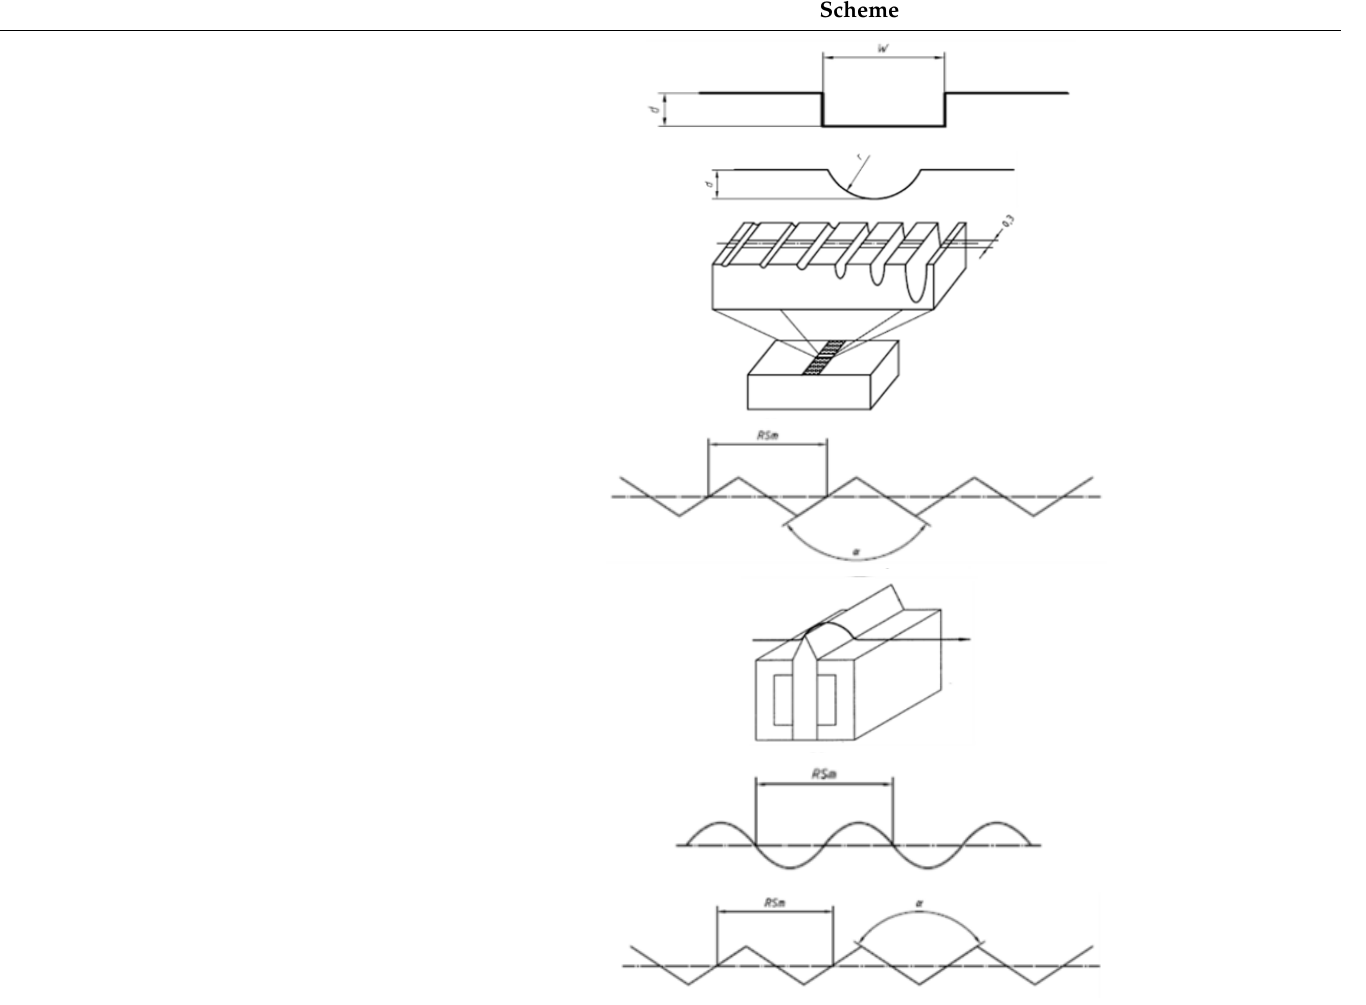
Table 2. Surface texture artifacts according to ISO 5436-1 [8,18,37].